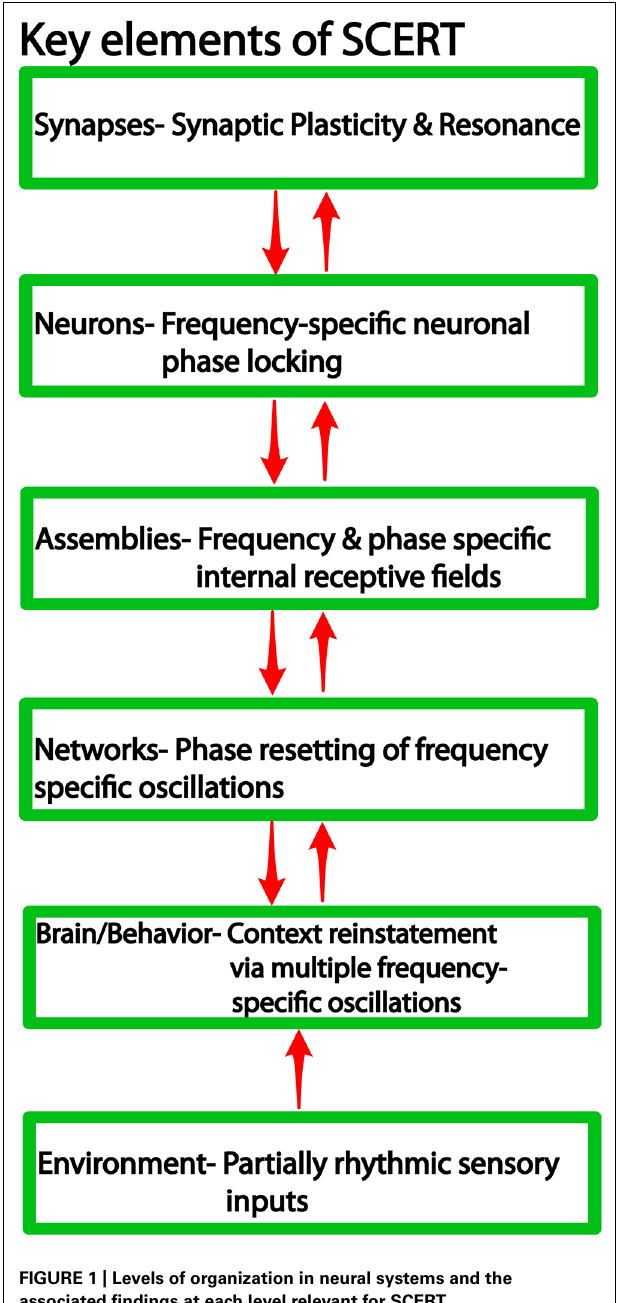
FIGURE 1 | Levels of organization in neural systems and the associated findings at each level relevant for